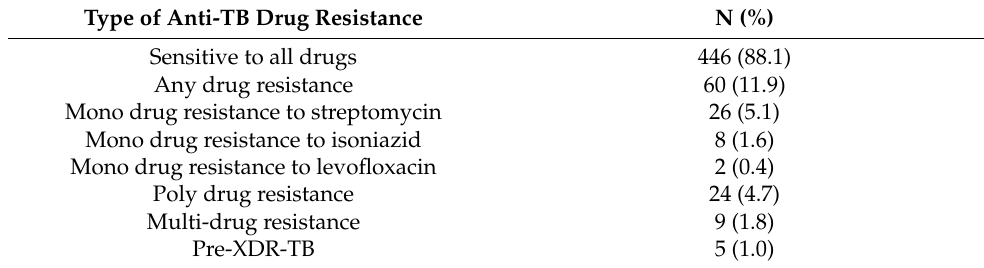
Table 3. Type of Anti-TB Drug